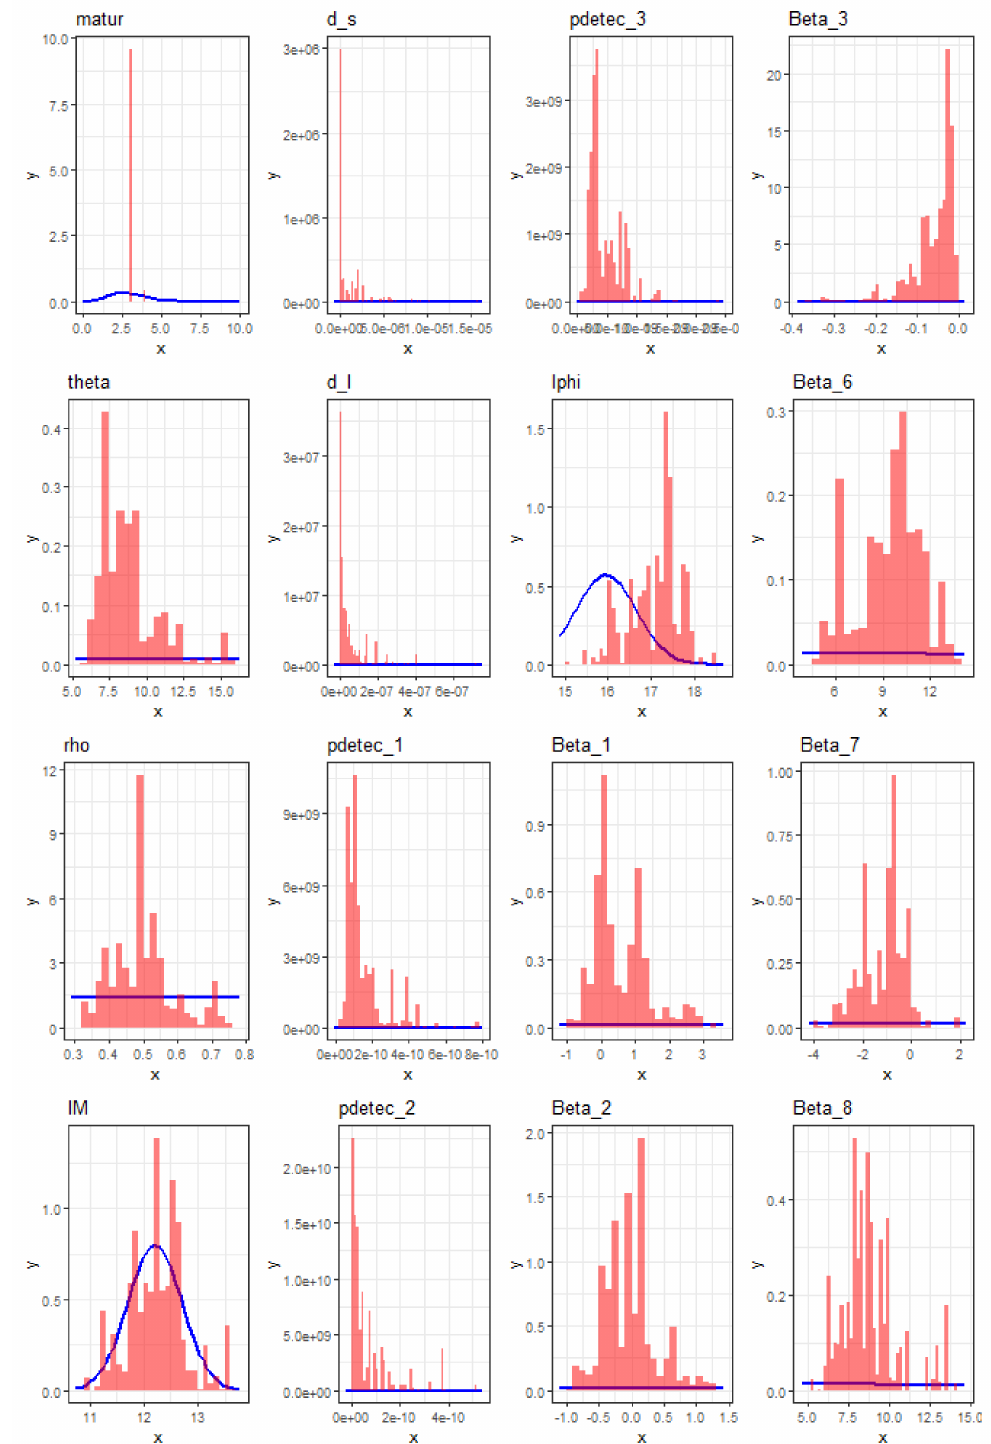
Figure A4. Posterior sample density (red histogram) and prior density (blue curve) for all 16 pa- rameters of the model, excluding the initial population parameters (see below) and β 4 , β 5 = 0. The deviation of the posterior sample density from the prior density enables us to visualize the information gained on the parameters from the